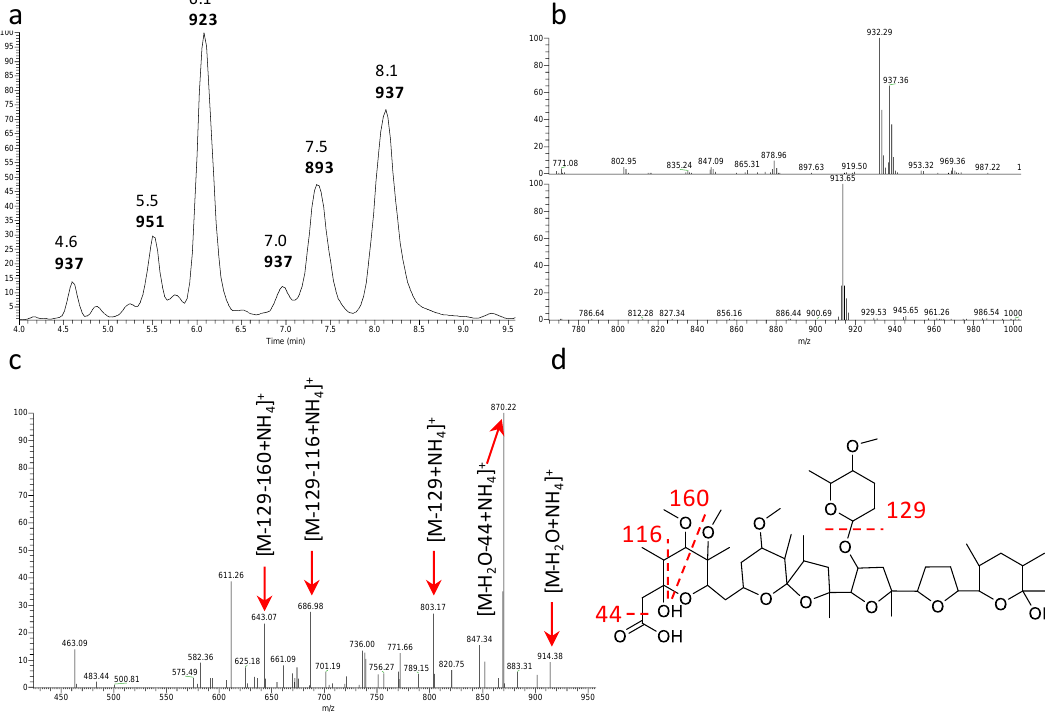
Figure 3. Analysis of α -823. ( a ) Base peak chromatogram of the 4.0–10.0 min portion with retention times and m/z [M+MH4] + values. Data obtained with a partially purified extract of Actinoallomurus sp. ID145823 (see Table S1 and Figure S7 for the congeners comparison); ( b ) mass spectrometry (MS) at 8.1 min in positive (above) and negative (below) ionization mode; ( c ) MS 2 analysis of m/z [M+NH 4 ] + 932; ( d ) putative fragmentation pathway for α -823.